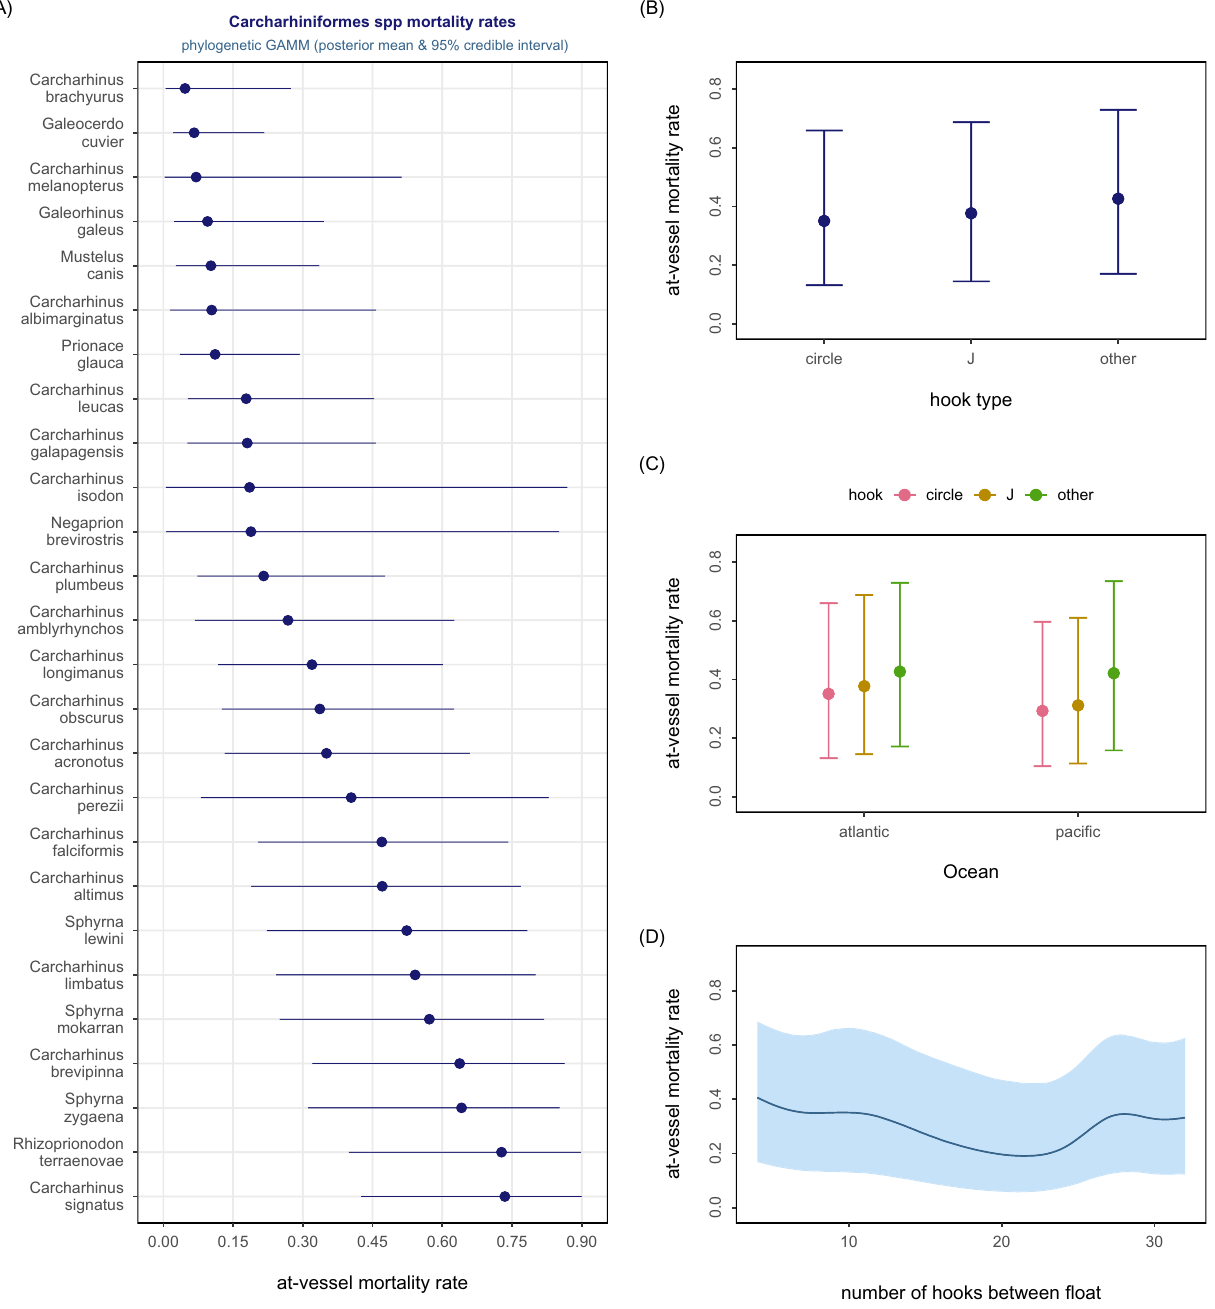
Figure 1. CARCHARHINIFORMES. Graphical summary of the Bayesian phylogenetic meta-regression model (binomial-Normal GAMM) fitted to 706 AVM effect sizes compiled for this 26 shark species clade. Panel ( A ) shows the estimated conditional species-specific AVM rate arranged from lowest to highest rate. Panel ( B ) shows the estimated conditional hook type effect on AVM. Panel ( C ) shows the estimated conditional effect of hook shape within ocean basin effect on AVM. Panel ( D ) shows the estimated conditional effect of number of hooks between floats on AVM. Solid dot = posterior mean, horizontal or vertical bar = 95% credible interval, solid curve = mean nonlinear trend, shaded polygon = 95% pointwise credible